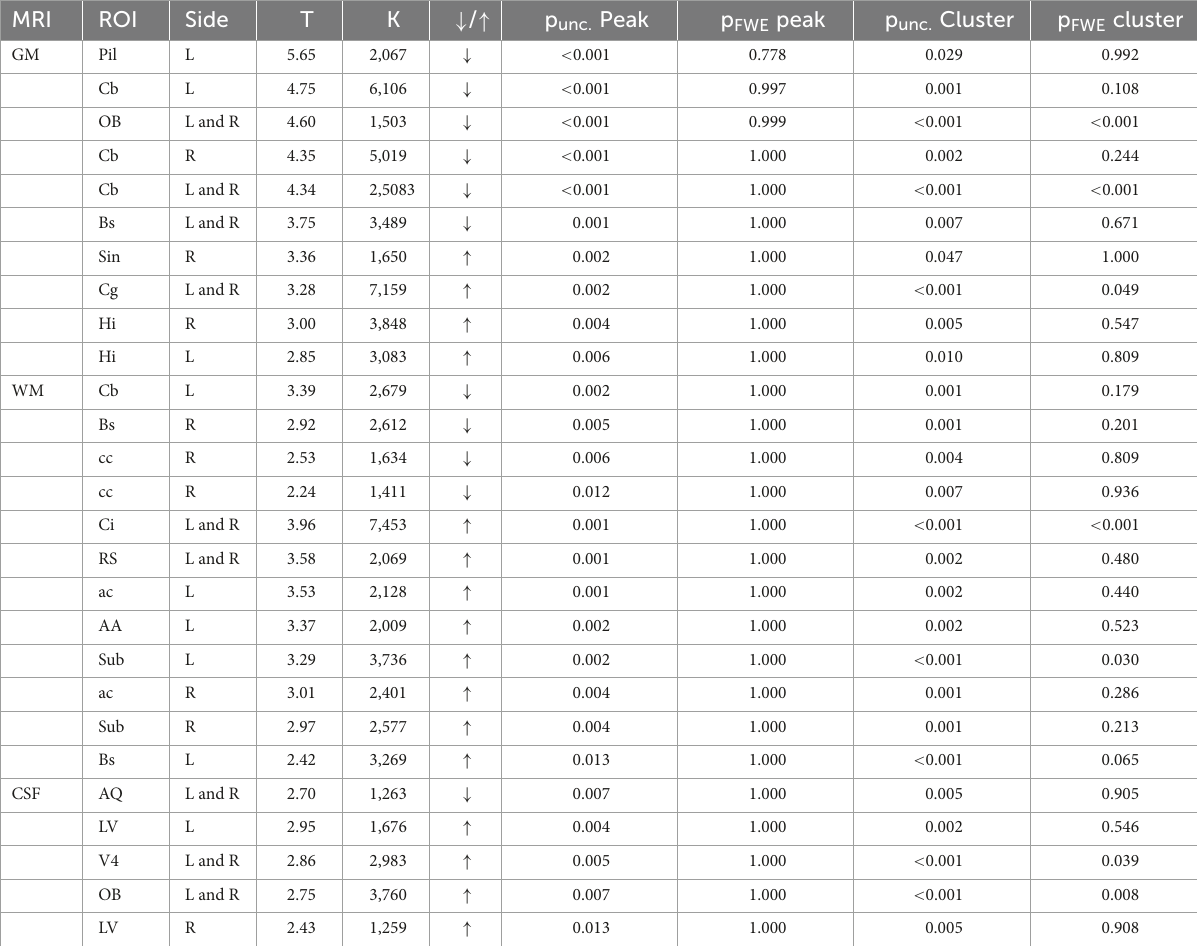
TABLE 2 Morphometric differences in adult MIS vs. Saline females resulting from voxel-based morphometry (VBM) analyses of gray matter (GM), white matter (WM), and cerebrospinal fluid (CSF).